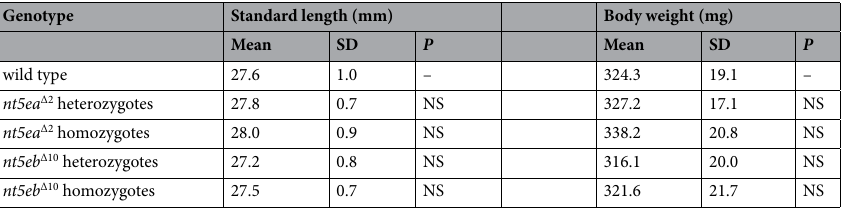
Table 1. Body size evaluation of wild-type and nt5e mutant medaka. The data shown were obtained with ten individual fish (n = 10 for each). NS means not significantly different from wild type with one-way ANOVA followed by Tukey’s HSD test ( P > 0.05).